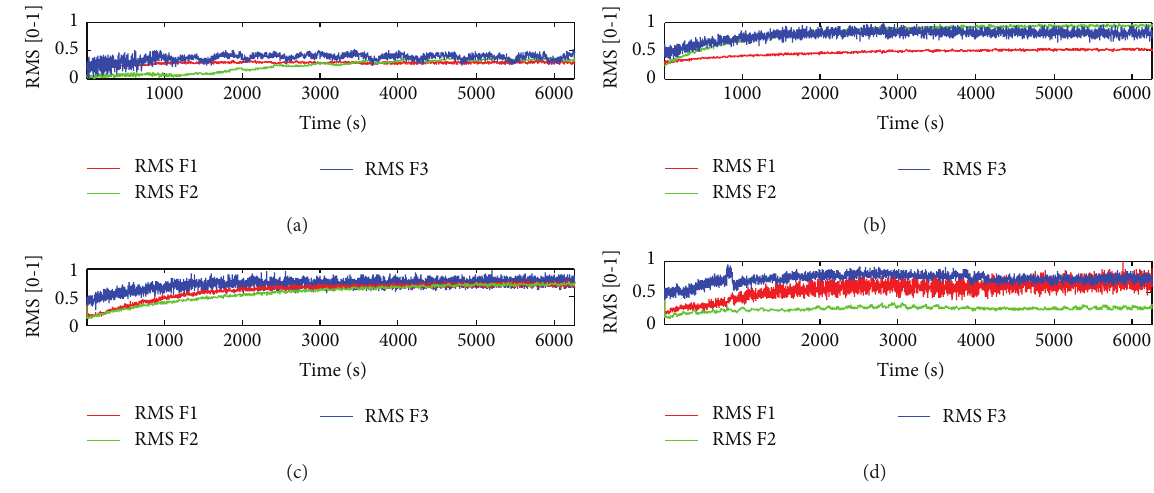
Figure 7: RMS of each filter output for all operating conditions: (a) HS, (b) BF, (c) FBRB, and (d) HBRB.